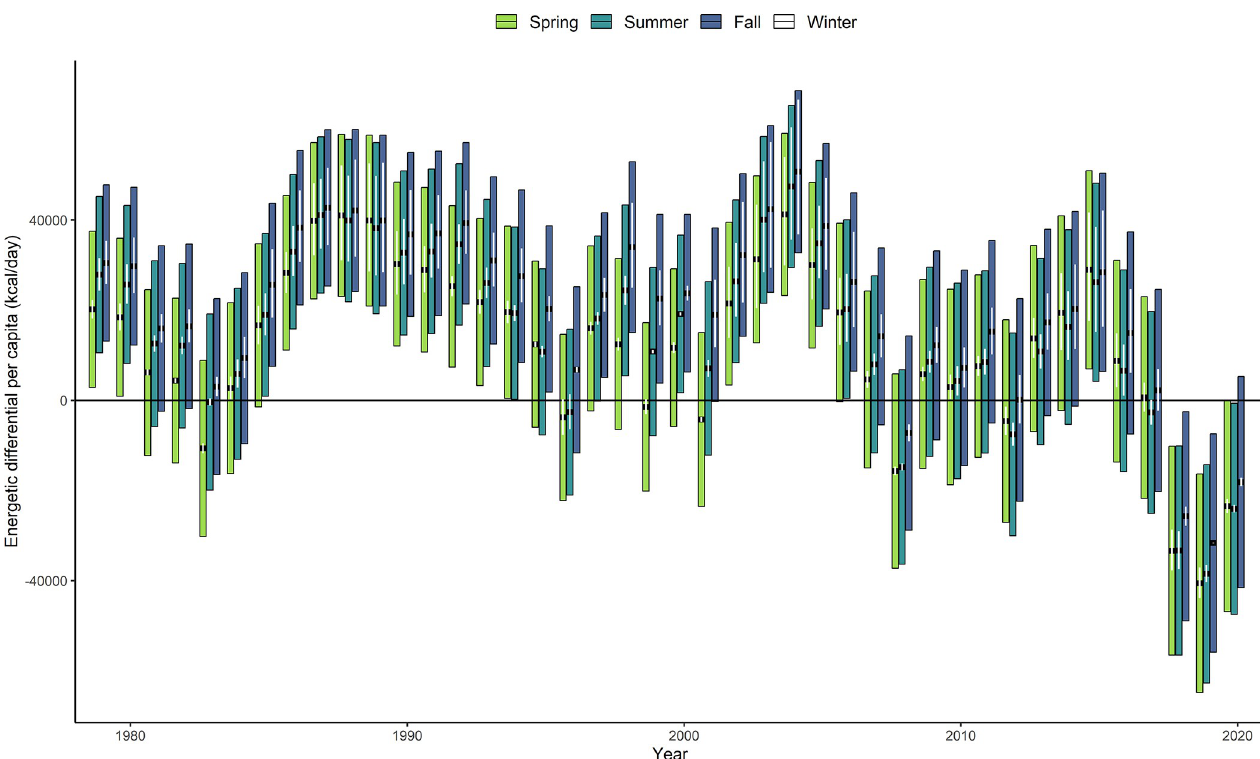
Fig 5. Energetic differential (kcal/day) between the energy ingested and the average DPER per whale individual. Each individual bar represents the highest and lowest DPER bound estimated by Noren et al. (2011), while the thick black dot represents the average DPER differential. The energetic differential was estimated in the spring, summer, and fall between 1979 and 2020. The white vertical lines represent the average DPER differential estimates when running the model with T s = 5h ±